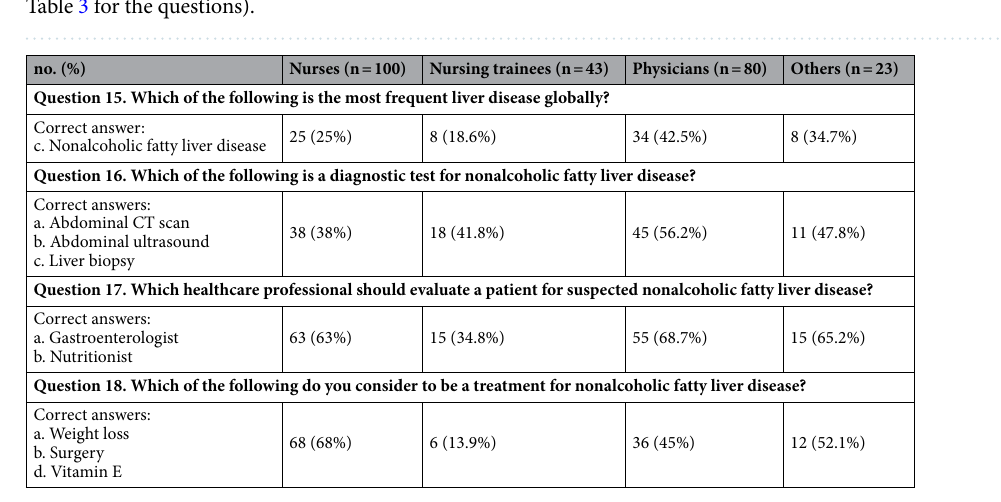
Table 3. Results from the “knowledge about diagnosis and treatment” questions.